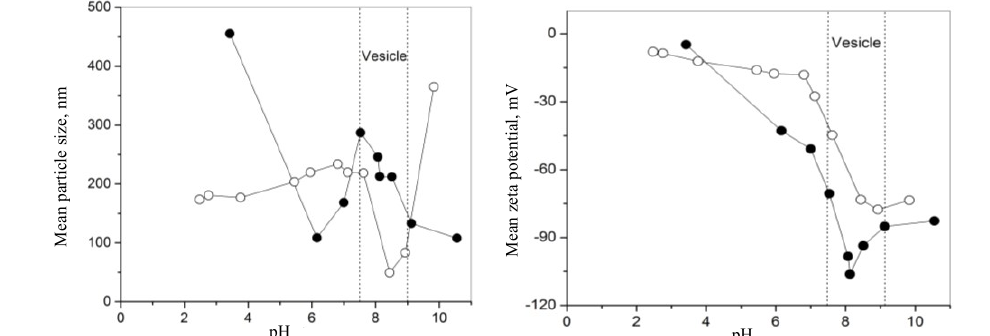
Figure 2. Mean particle size of 12.5 mM linolenic acid (●) and 12.5 mM PEGylated linolenic acid (○) at various pH.